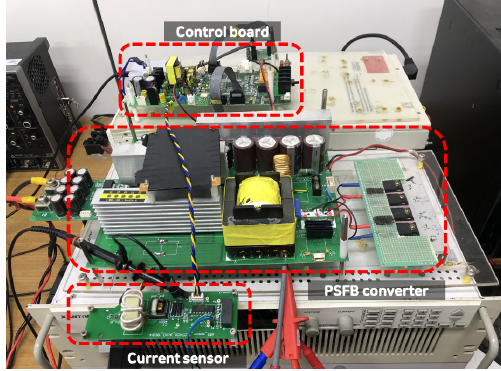
Figure 19. Experimental circuit